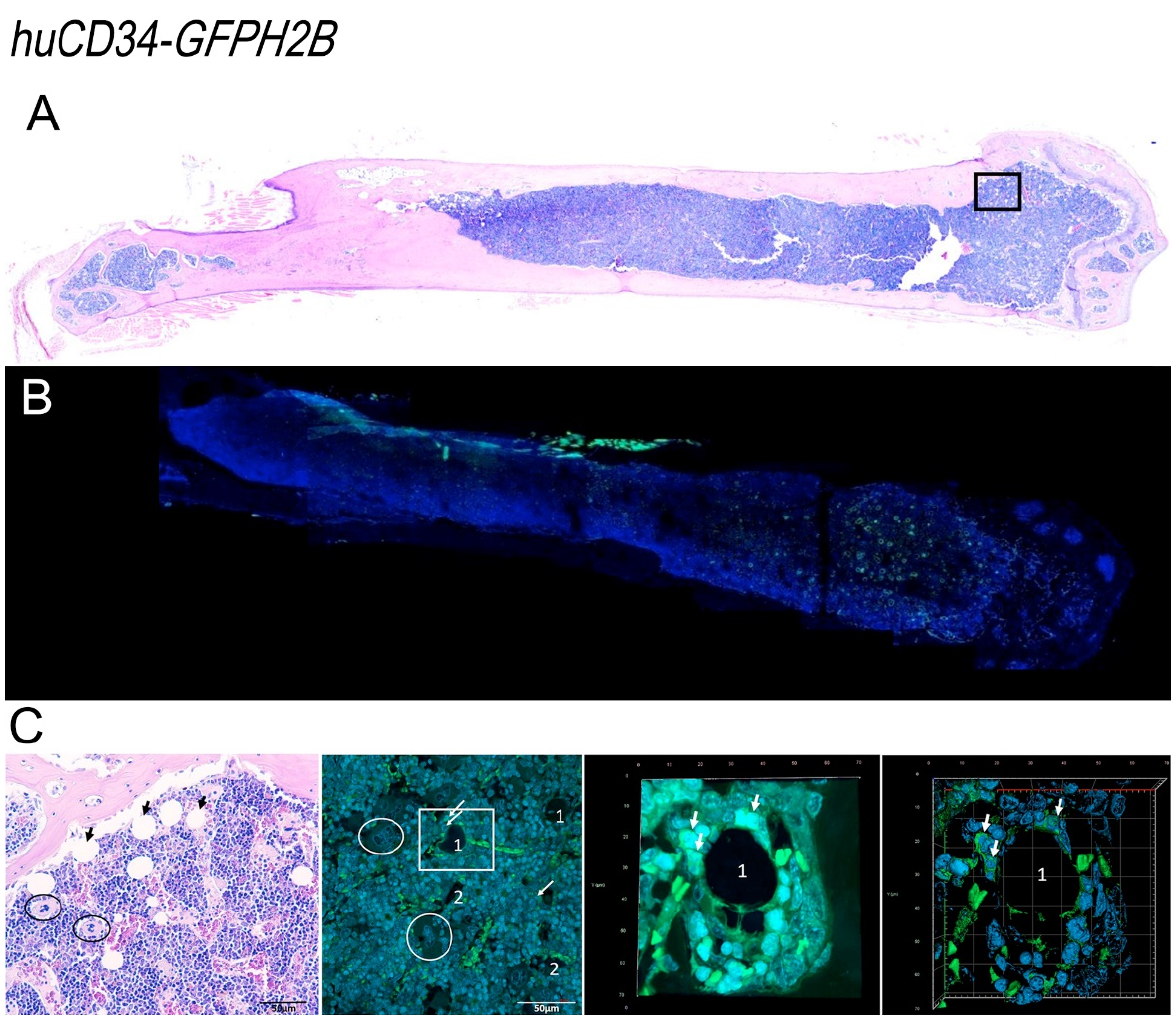
Figure 9. Confocal microscopy analyses of the distribution of GFP-positive cells within the bone marrow architecture of huCD34-GFPH2B mice. ( A ) The H&E staining of a femur section from one representative huCD34-GFPH2B mouse reveals hypercellular bone marrow with scant residual adipocytes well visible in H&E figure in C. ( B ) Confocal microscopy analyses with GFP and DAPI of a femur from one representative huCD34-GFPH2B mouse revealing that GFP+ cells are mostly distributed in the epiphysis of the femur. ( C ) Representative panels showing, at larger magnification, the areas indicated in rectangles in A (H&E staining, left panel) and in B (confocal microscopy, second panel of the left). The rectangle on the second panel on the left is shown as stack image and as tridimensional reconstruction on the right. The tridimensional reconstruction is shown in detail in movie 3. Black arrows in A indicate adipocytes, circles indicate megakaryocyte clusters, and white arrows indicate GFP-positive cells. A and B are a photo-merge of 4 × magnification pictures; in C, the magnifications are 20 × for the first and second panel, and 40 × for the third and fourth panel. In agreement with the flow cytometry data indicating that in the bone marrow of huCD34-GFPH2B/Gata1 low mice GFP high SLAM cells are very few, the spleen from Gata1 low mice contained much more GFP+ cell than that from huCD34-GFPH2B mice (data not shown). In addition, in huCD34- GFPH2B/Gata1 low mice, the nuclear fluorescent intensity in the cells from the spleen was significantly greater than that from the cells of the bone marrow (17.85 ± 12.98 vs. 6.88 ± 4.47 mean fluorescent intensity/cell in the spleen and in bone marrow, respectively). These data confirm previous observations indicating that in Gata1 low mice, a vast majority of the SLAM are in the spleen